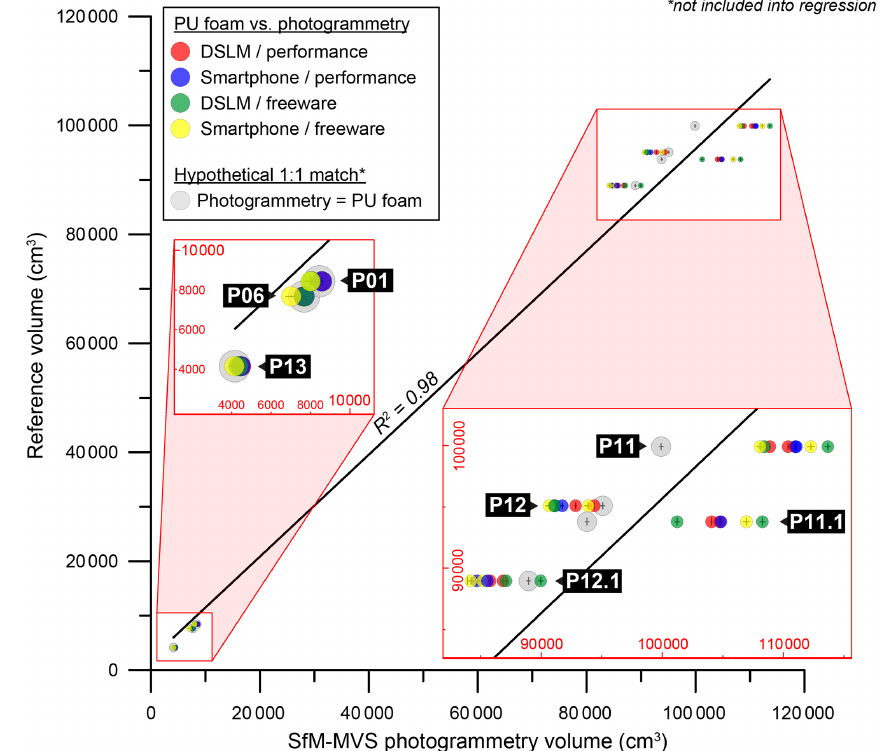
Figure 7. Pit (BD17-P01 to BD17-P12.1) and cavity (BD17-P13) volumes derived using PU foam/polystyrene casts (reference volumes) and the SfM-MVS photogrammetry workflows tested in this study. Hypothetically matching values obtained from the PU foam/polystyrene casts are indicated by large grey circles (errors of these values on the ordinate reflect measurement standard deviations; errors on the abscissa reflect the standard deviation of all photogrammetric reconstructions as determined on the artificial pit, i.e. ∼ 169cm 3 ; Table 2). For discussion, see